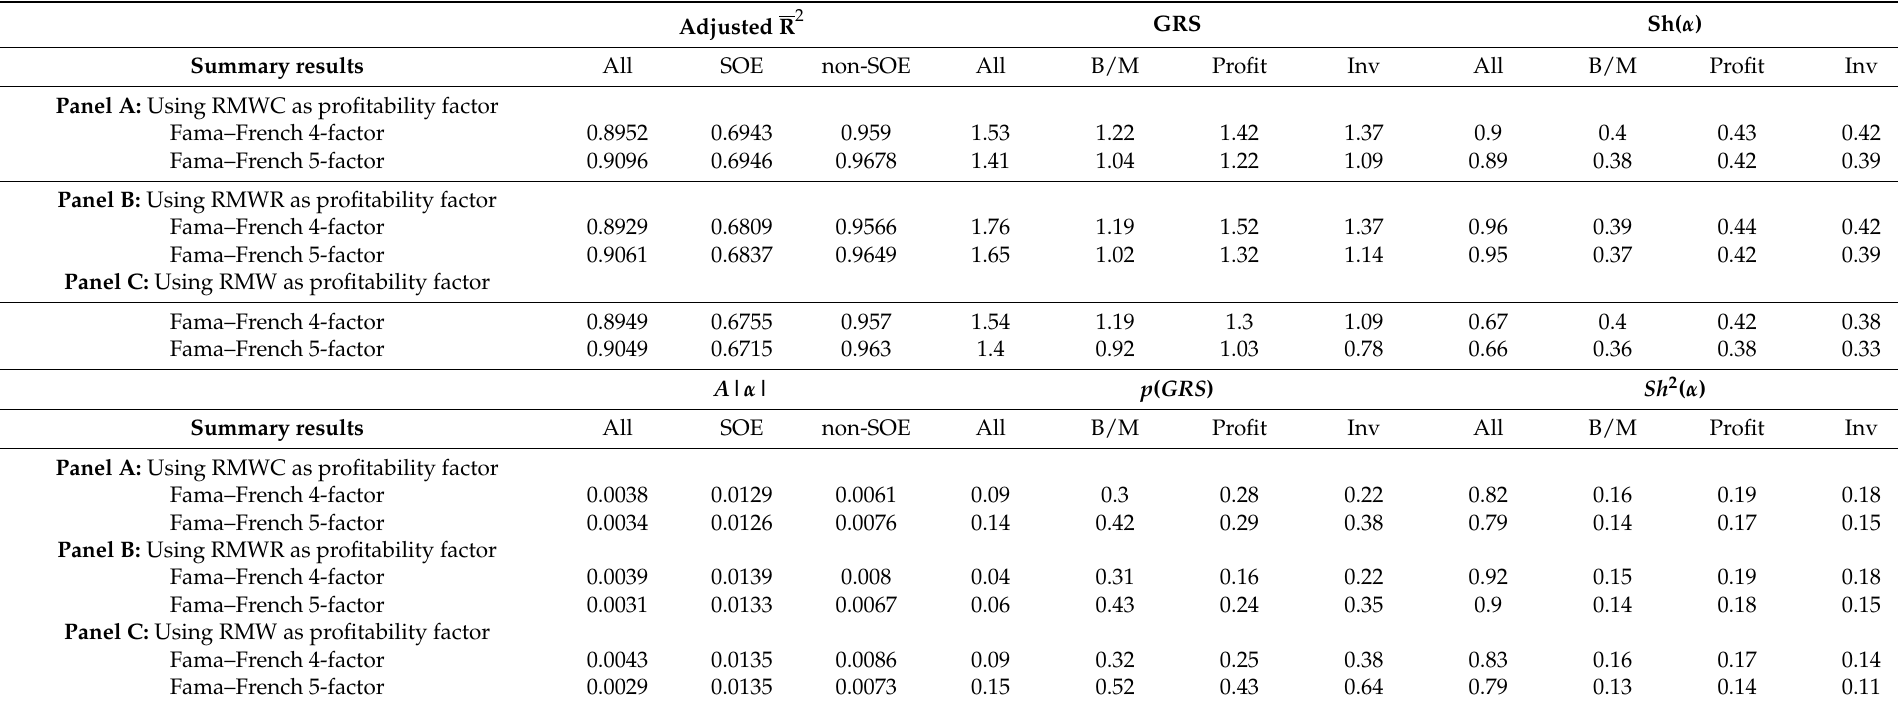
Table 8. Summary of the regression results using cash profitability and ROE profitability factors. Panel ( A ) of this table describes the average adjusted R-squared of all portfolios sorted by size and a combination of B/M, profitability, investment and the average adjusted R-squared of size-All (All), size-SOE (SOE) and size-non-SOE sorted (non-SOE) portfolios. The portfolio formation and book-to-market (HML), cash profitability (RMWC) and investment (CMA) factor construction follow Fama and French’s (1993, 2015, 2018) methodology. Summary results show the average value of all adjusted R-squared (Adj.R 2 ) and the absolute intercepts ( A| α | ) of all portfolios from the respective regressions in panels A to D of Table 6. GRS is the Gibbons et al. (1989) test statistic and its p -value, p ( GRS ). Sh ( α ) and Sh 2 ( α ) are the Sharpe ratio for intercepts and its maximum squared value, respectively. We apply these five tests to all portfolios (All) and the portfolios formed by size and a combination of book-to-market (B/M), profitability (OP), investment (Inv). Column “SOE” shows the results for companies classified as state-owned and “non-SOE” column reports the results on the privately owned group of listed firms. Fama–French five-factor model with